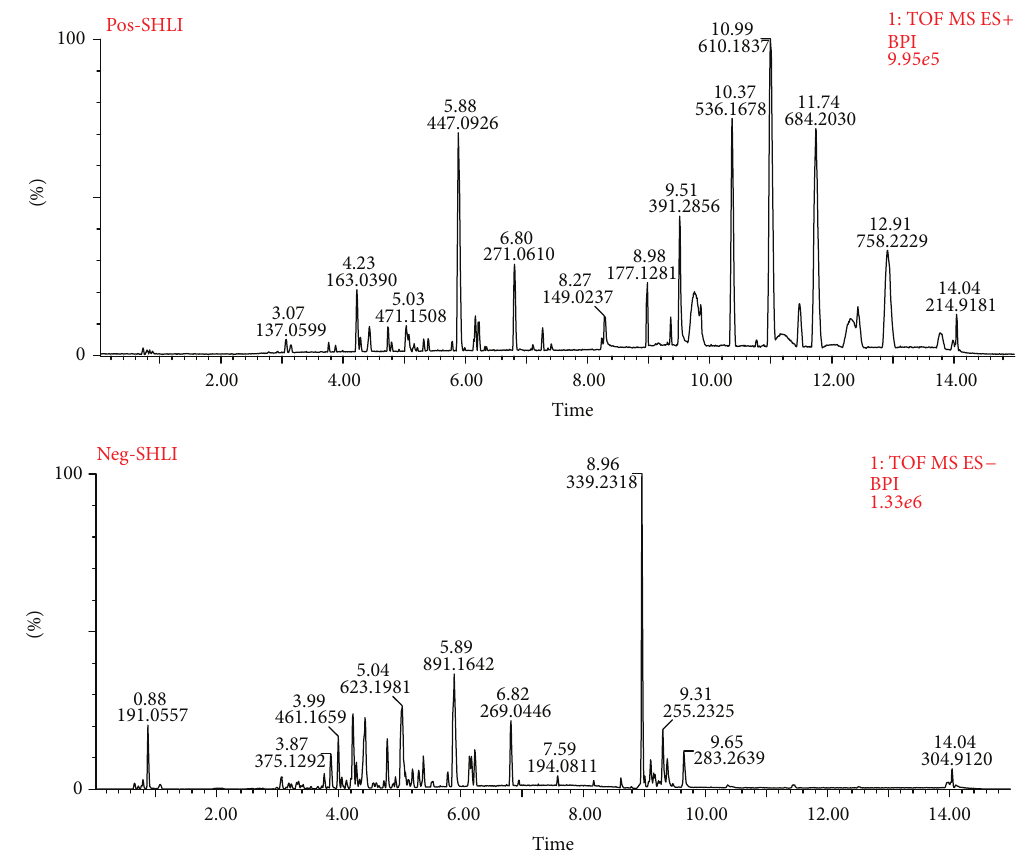
Figure 1: UPLC-Q-TOF/MS BPI chromatograms of SHLI in positive ion mode and negative ion mode.